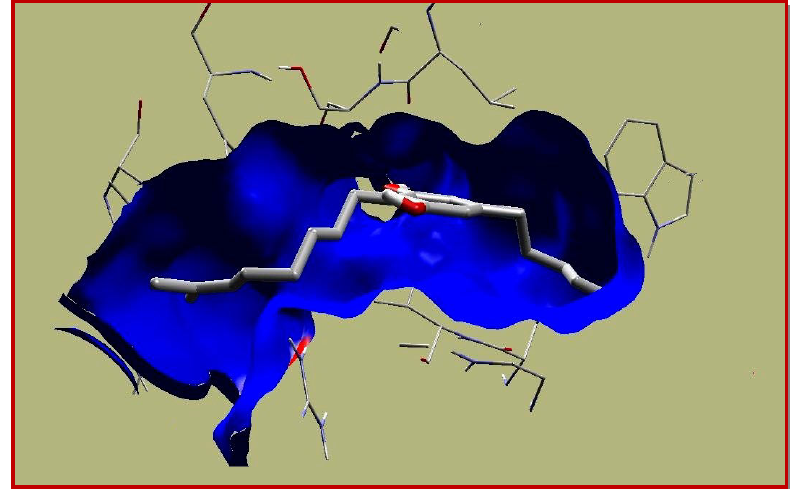
Figure 4: Favorable steric interactions of cannabigerol inside COX-2 binding pocket